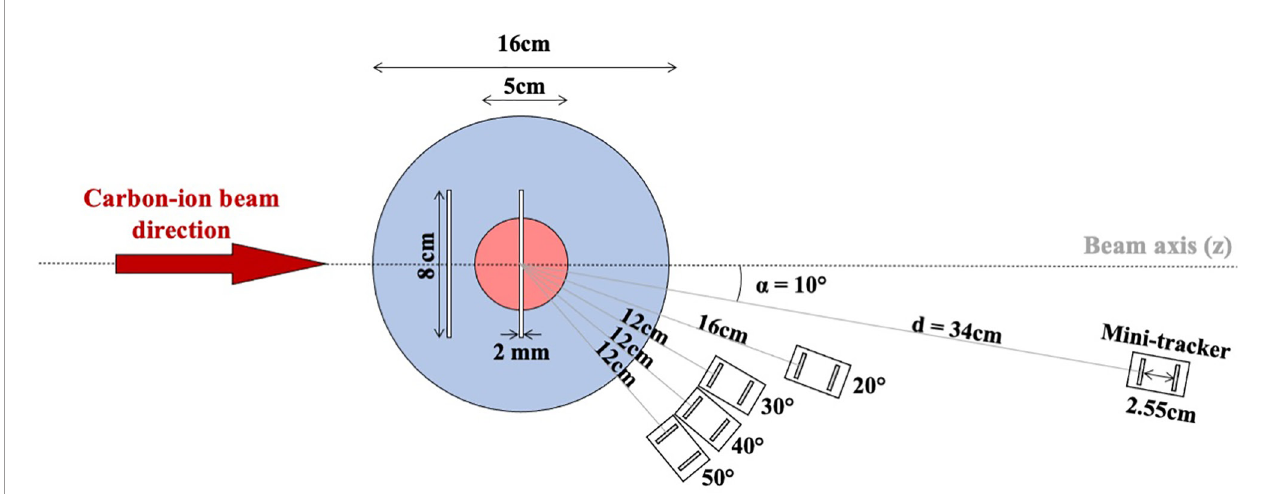
FIGURE 2 | Schematic top view of the experimental set-up. The blue circle represents the cylindrical head phantom and the red circle represents the irradiated spherical tumor volume. The vertical white bars represent the positions of the air cavity (either upstream of the tumor volume or at the isocenter). The distance between the room isocenter and the front detector of the mini-tracker is denoted as d and a is the angle of the mini-tracker axis with respect to the axis of the treatment fi eld direction (beam axis). The following mini-tracker positions were investigated: 10° at a distance d of 34 cm, 20° at a distance of 16 cm, and 30°, 40°, and 50° at a distance of 12